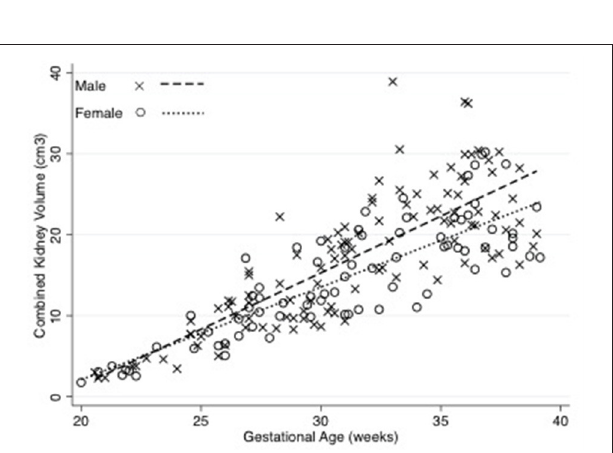
FIGURE 4 | Comparison of birth weight between neonates of smoking and non-smoking mothers. Babies of mothers that smoked were smaller at birth than babies born from non-smoking mothers ( P = 0.001). Median weight and interquartile range: smoking group = 3,140g [IQR = 685], non-smoking group